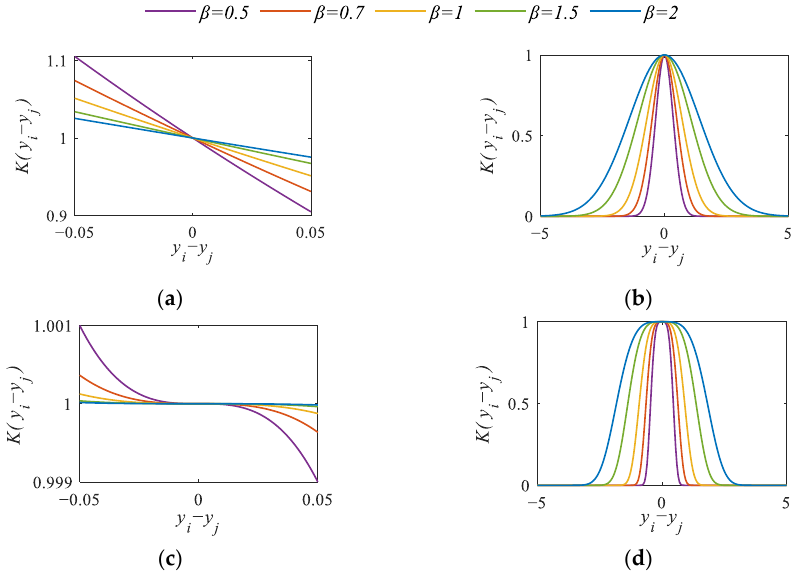
Figure 2. The curves of Weibull kernel function with different parameters: ( a ) γ = 1; ( b ) γ = 2; ( c ) γ = 3; ( d ) γ = 4. ( c ) γ = 3; ( d ) γ =